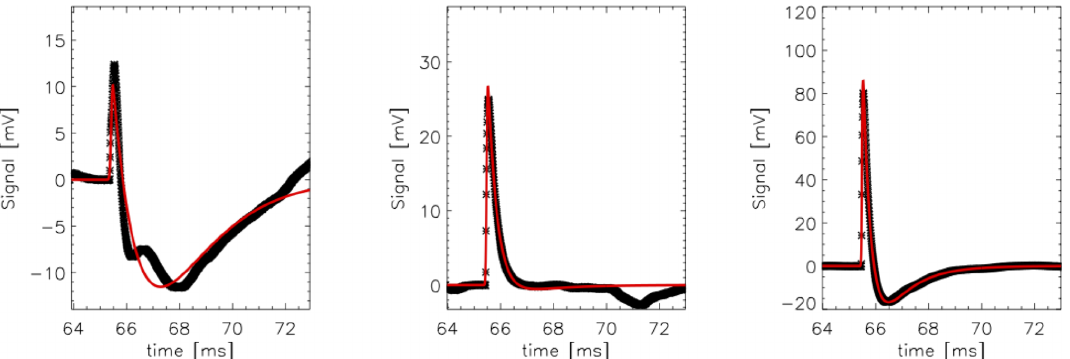
Figure 5. Dust impact signals recorded by the STEREO/WAVES TDS on STEREO A, shown with black crosses, are shown in comparison to a fit with a semi-empirical model, discussed in the text, shown with red solid lines (from Zaslavsky et al.,